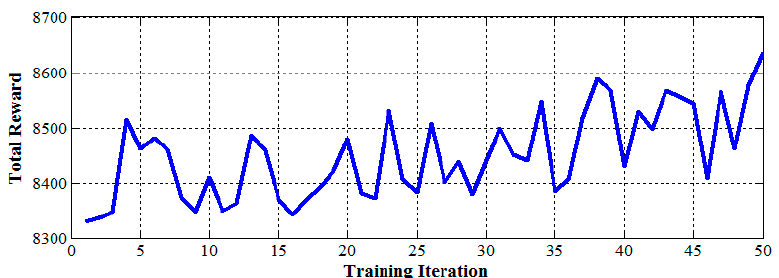
Figure 6. Track of the total reward.